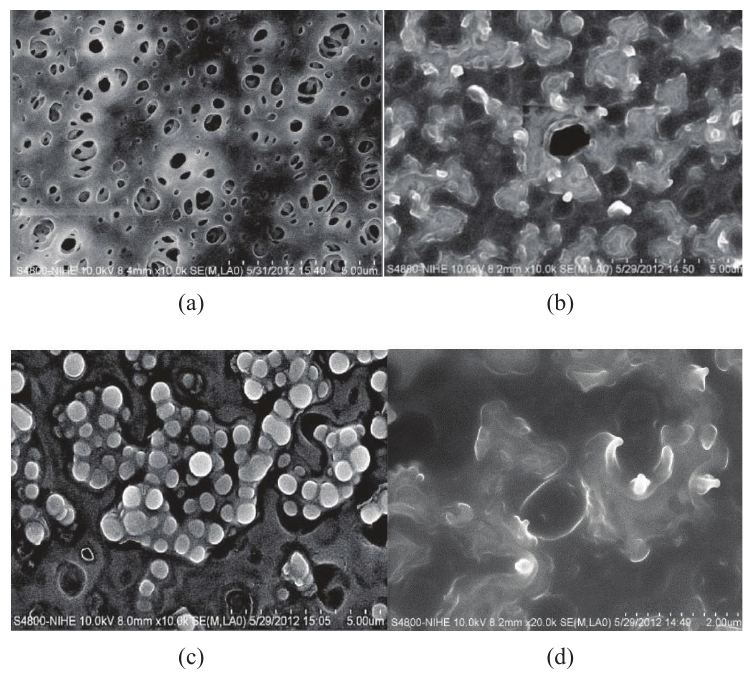
COO], c: after im­ 3 ]) 4